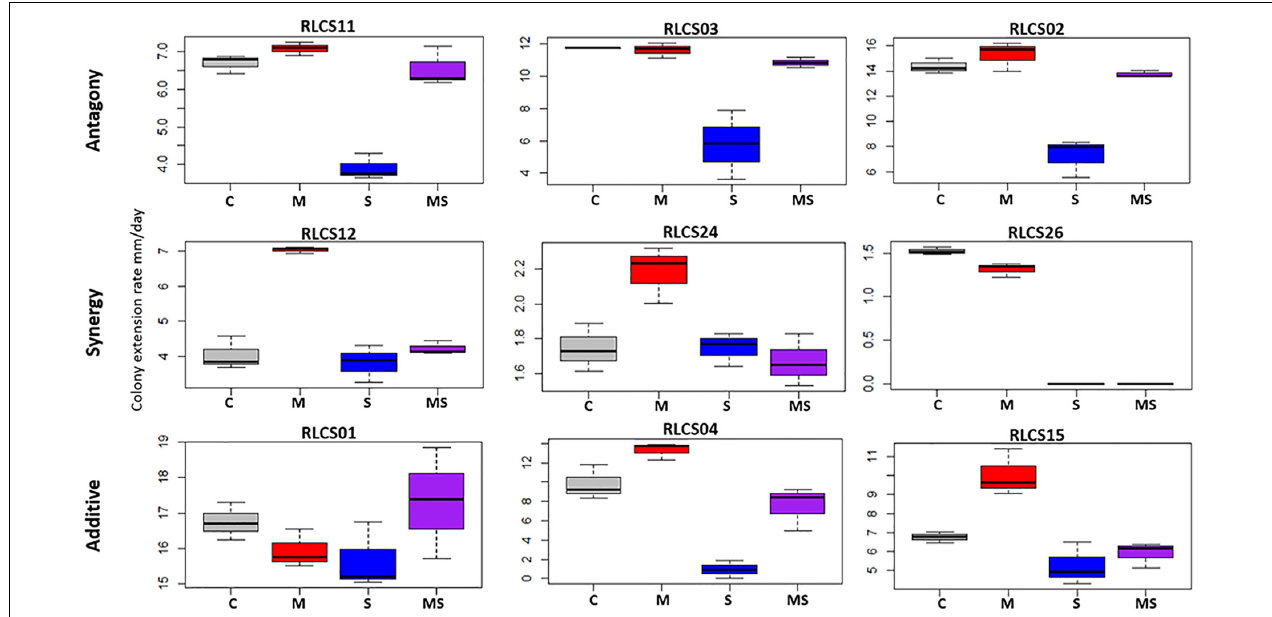
FIGURE 2 | Examples of response categories (based on colony extension rate) to applied recurrent heat pulse perturbations: antagony (shown are 3 of the 13 isolates so categorized), synergy (all 3 isolates in this category are shown), additive (3 of the 16 isolates so categorized are depicted). For a full figure containing data for all 32 isolates see Supplementary Figure S1